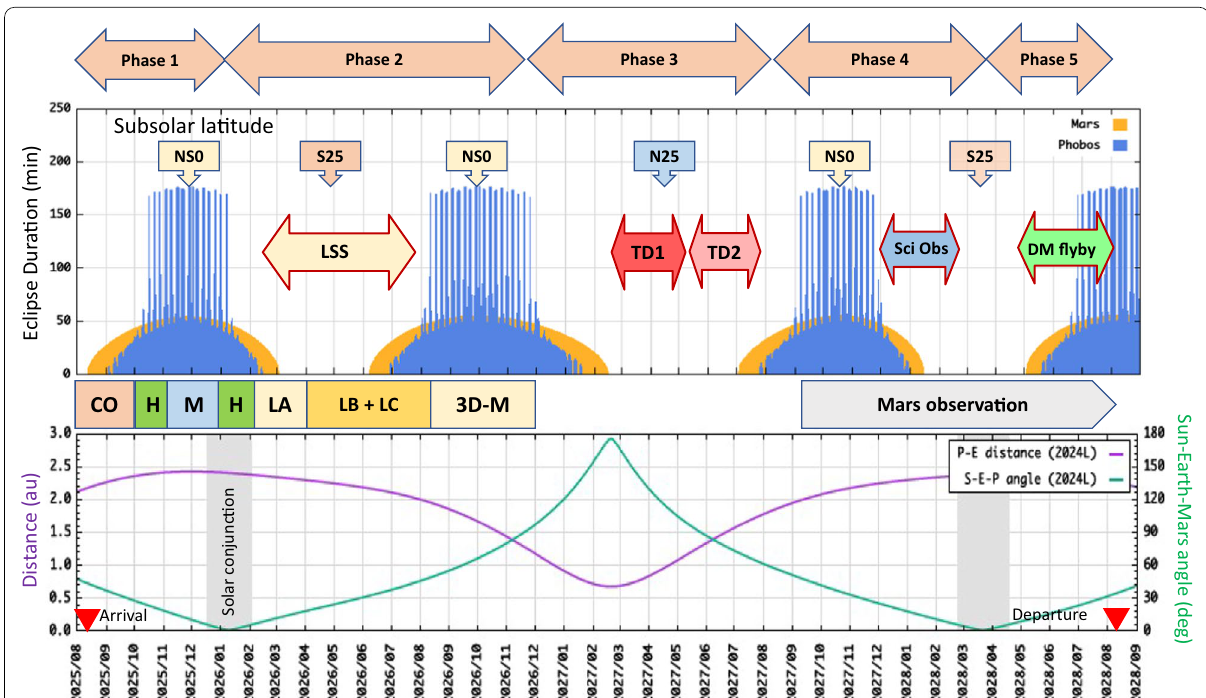
Fig. 4 Outline of the tentative operation plan of MMX during the 3‑year stay in the Martian system. The two panels are based on changes in the duration of eclipses by Mars and Phobos (top) and those in the configuration of Mars relative to the Sun and Earth (bottom), respectively. Horizontal axes are common and the timings of arrival and departure are shown on the bottom horizontal axis. For eclipse duration estimates (orange hatches by Mars and blue ones by Phobos), a QSO‑L orbit is assumed. The purple and green curves in the bottom panel show the distance between Phobos and Earth and the separation angle between the Sun and Phobos seen from the Earth, respectively. N25, S25, and NS0 represent the subsolar latitudes on Phobos at the timings of solstices and equinoxes of Mars. CO check out, H QSO‑H, M QSO‑M, LA QSO‑LA, LB QSO‑LB, LC QSO‑LC, LSS landing site selection, TD touch down, DM Deimos, 3D-M three‑dimensional QSO‑M. Courtesy of Nakamura T and Ikeda